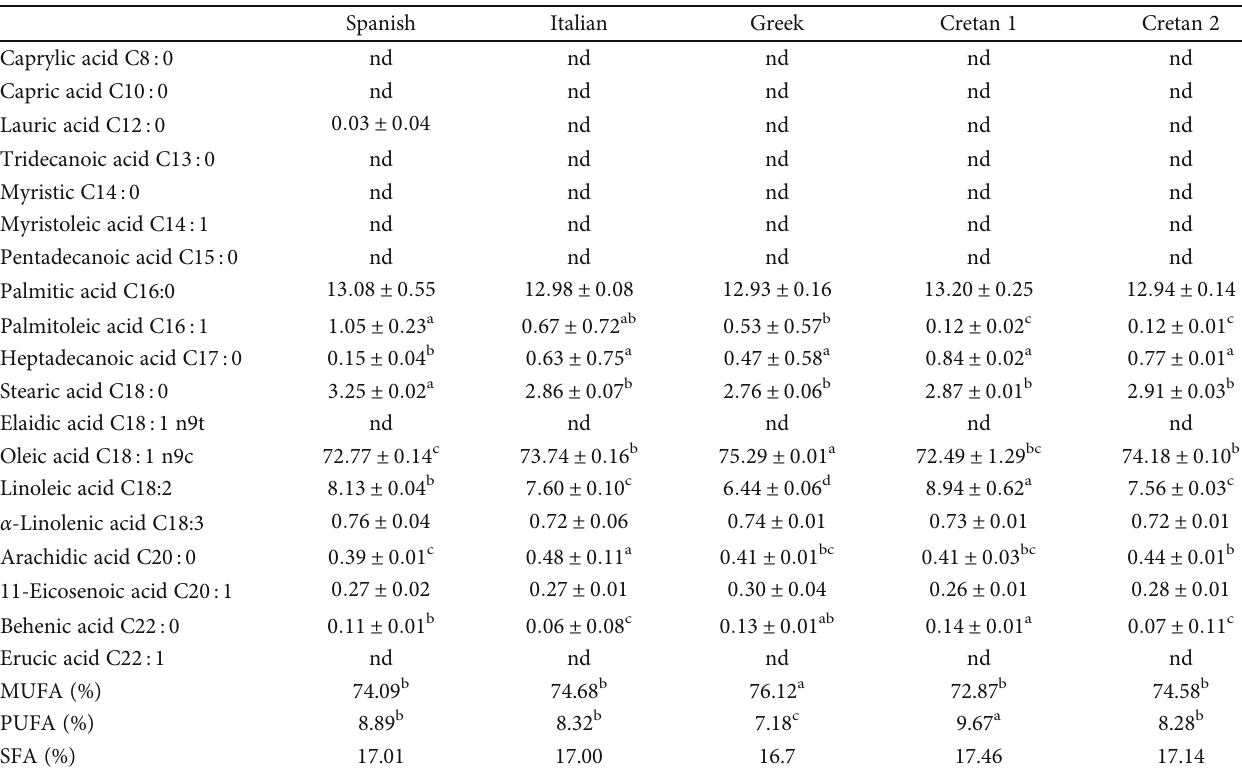
Table 2: Fatty acid pro fi le of extra virgin olive oils (%). Spanish